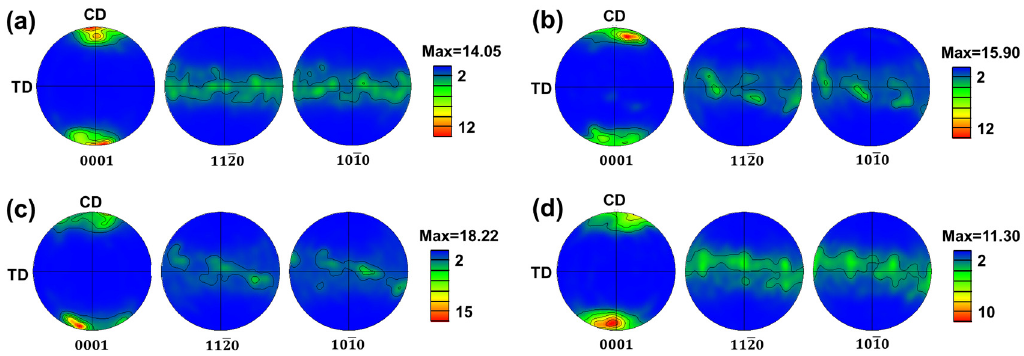
Figure 9. Pole figures of Mg-3Sn-2Al-1Zn-0.6Nd alloy under different hot deformation conditions: